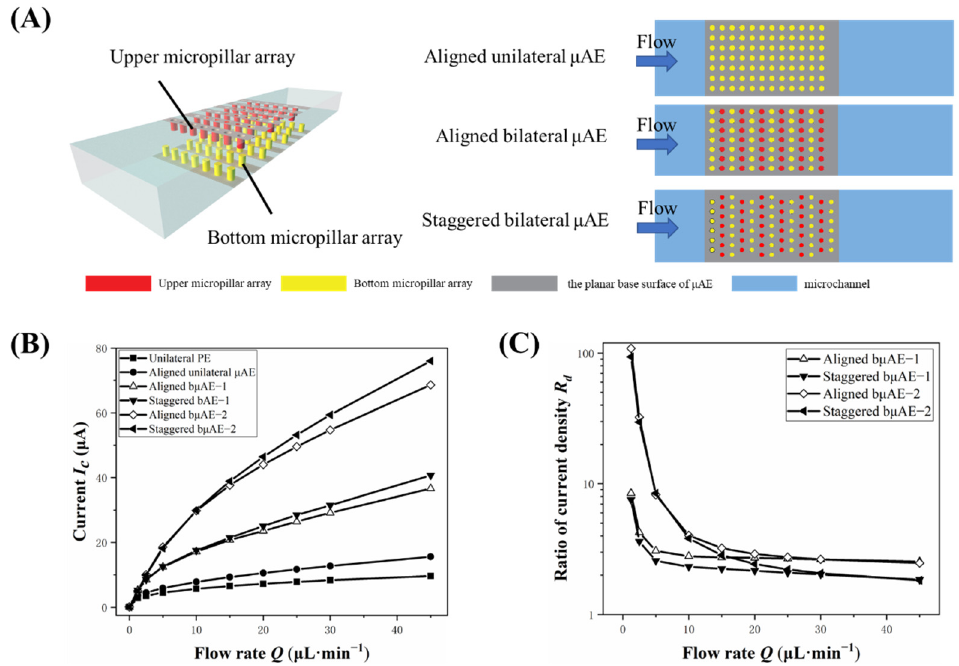
Figure 5. ( A ) The schematic diagram of the layout of the unilateral µAE and the bµAE. ( B ) Current responses of the PE, the unilateral µAE and bilateral µAEs in different layouts under varying flow responses of the PE, the unilateral µ AE and bilateral µ AEs in different layouts under varying flow rates; ( C ) The current density ratios of these bµAEs in different layouts under varying flow rates. rates; ( C ) The current density ratios of these b µ AEs in different layouts under varying flow rates. The tail effect in the bµAE with different layouts was then investigated in Figure 5C. The tail effect in the b µ AE with different layouts was then investigated in Figure